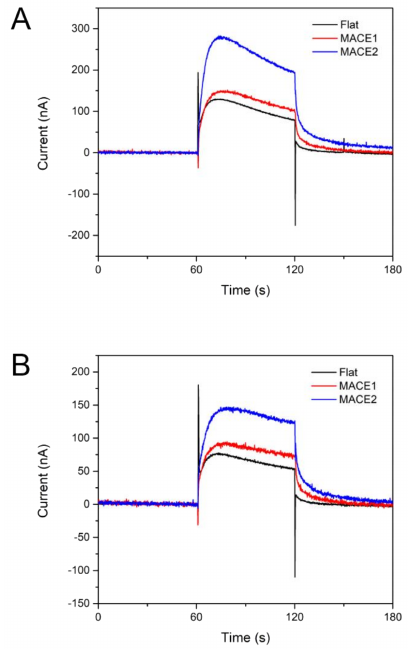
Figure 6. Photosynthetic currents from thylakoid-deposited flat, MACE1, and MACE2 electrodes during the ( A ) first and ( B ) second cycle of illumination. Each cycle lasted for 60 s.